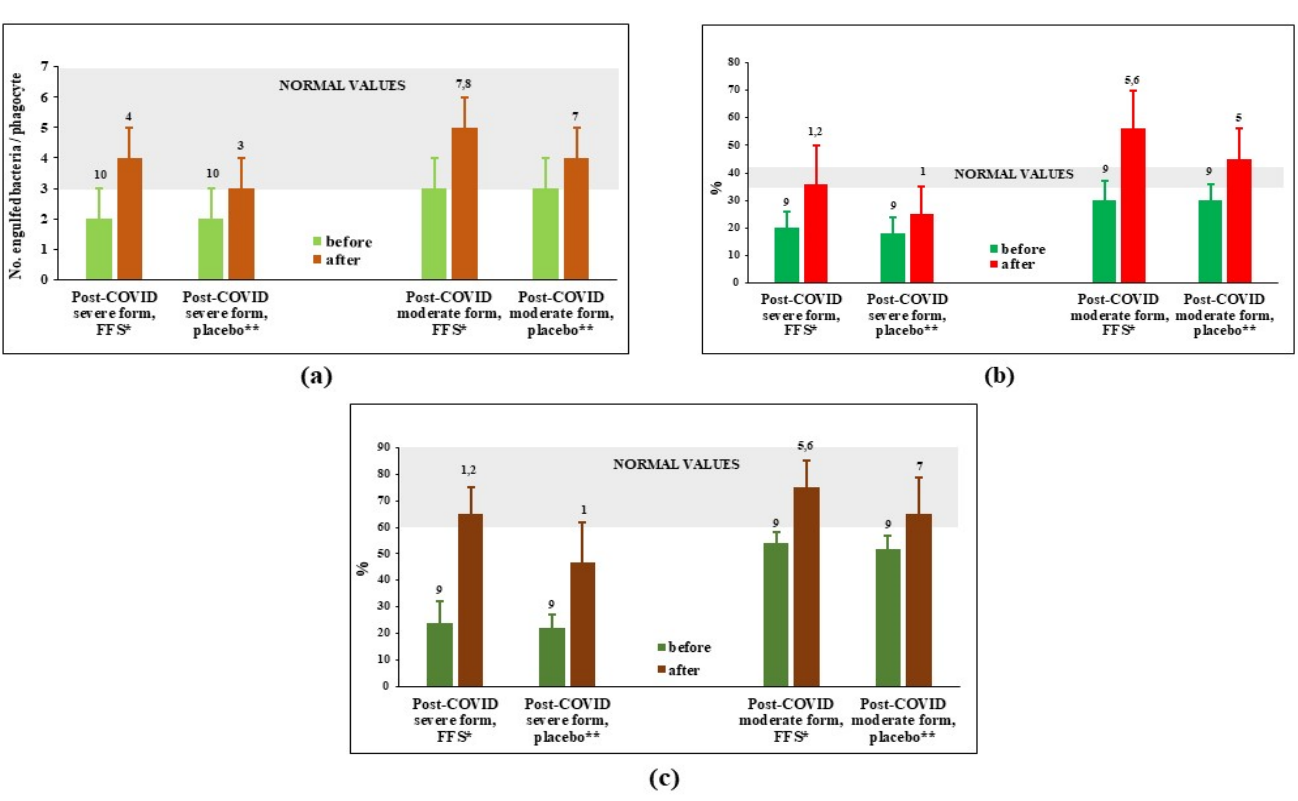
Figure 1. Phagocytosis parameters of circulating polymorphonuclear leukocytes (PMN) before and after the clinical trial. ( a ) Number of engulfed bacteria per single cell; ( b ) actively phagocytosing PMN, phagocytosis index (%); ( c ) intensity of intracellular killing (%). * FFS-Fermented fruit supplement, 28 g daily for 20 days; ** Placebo-diluted 5% honey 28 g daily for 20 days. Grey area covers normal range of values. 1 p < 0.01 vs. post-COVID severe placebo group before supplementation; 2 p < 0.01 vs. post-COVID severe FFS group before supplementation; 3 0.05 < p < 0.1 vs. post-COVID severe placebo group before supplementation; 4 0.05 < p < 0,1 vs. post-COVID severe FFS group before supplementation; 5 p < 0.01 vs. post-COVID moderate placebo group before supplementation; 6 p < 0.01 vs. post-COVID moderate FFS group before supplementation; 7 0.05 < p < 0.1 vs. post-COVID moderate placebo group; 8 0.05 < p < 0.1 vs. post-COVID moderate FFS group before supplementa- tion; 9 p < 0.01 vs donors; 10 0,05<p<0,1 vs. donors.